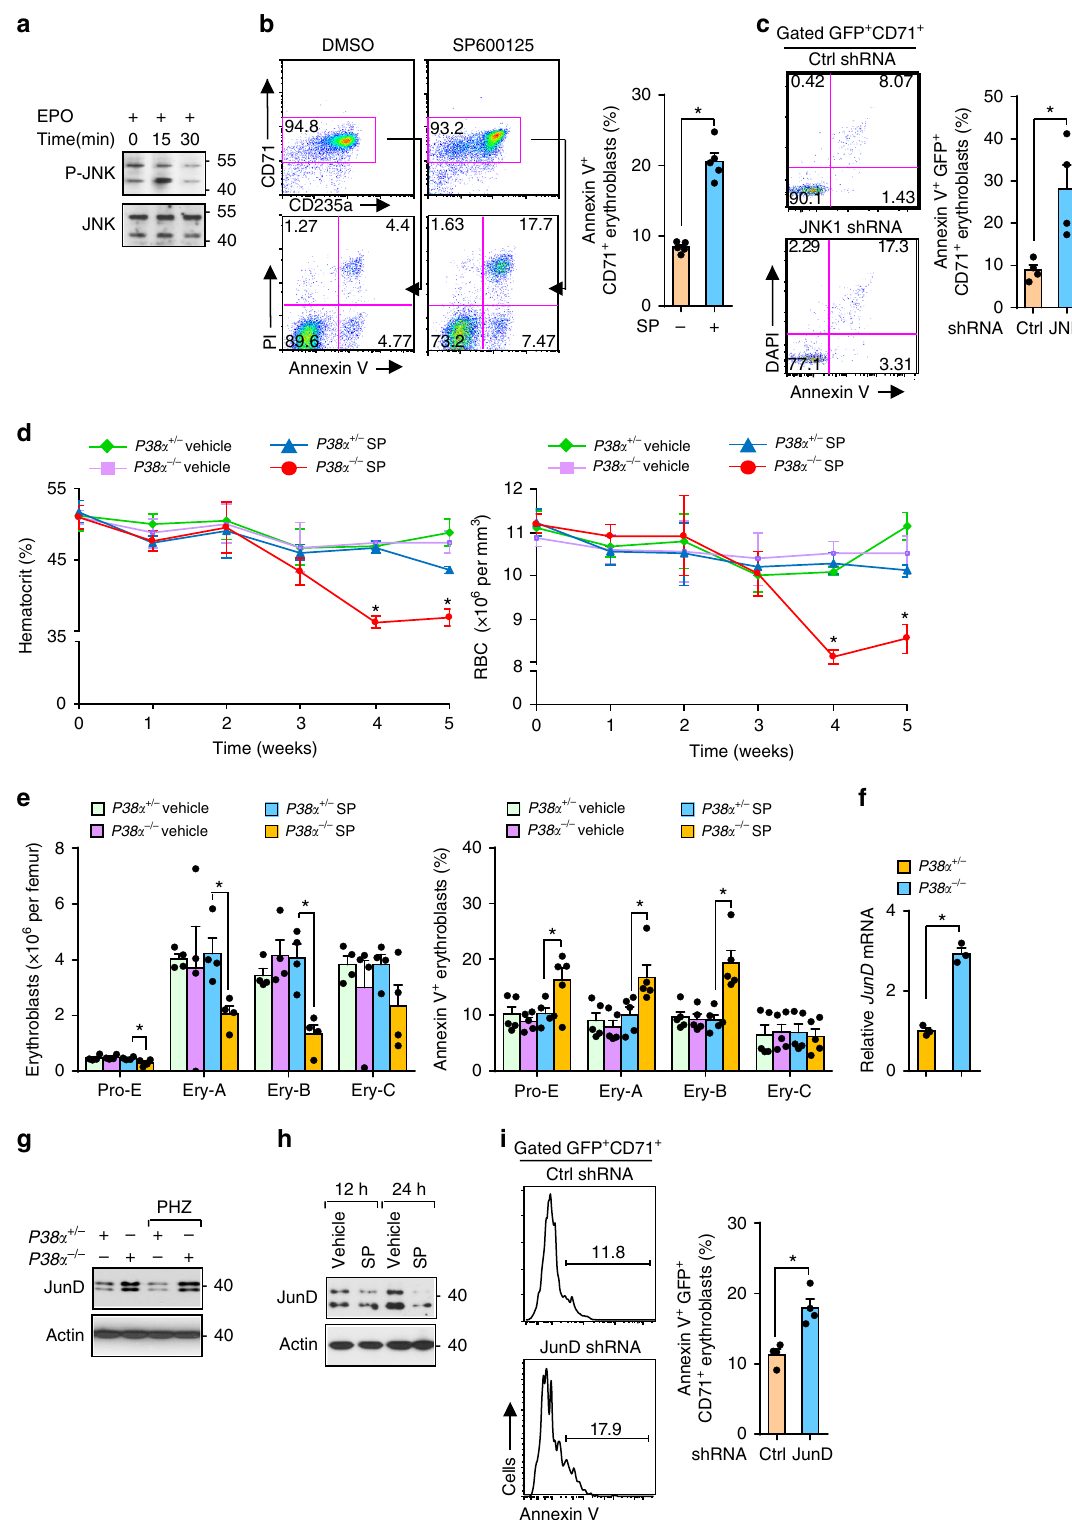
Ery-A Ery-B Ery-C Pro-E